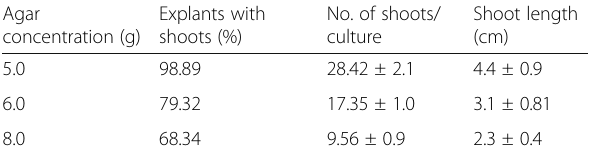
Table 2 Effect of agar concentration on development of shoots from shoot tip explants of T. roylei inoculated onto half-strength MS